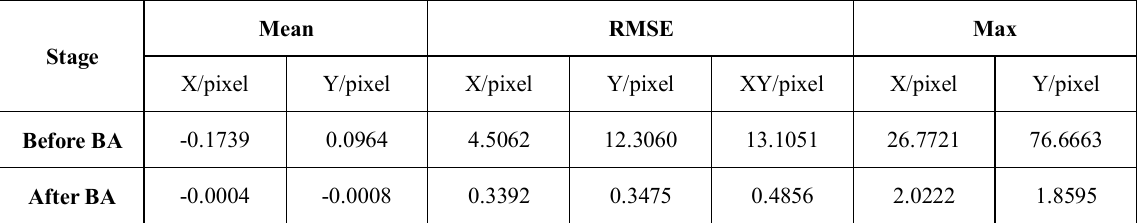
Table 2. The statistics of the relative image residuals of TPs in the whole block before and after